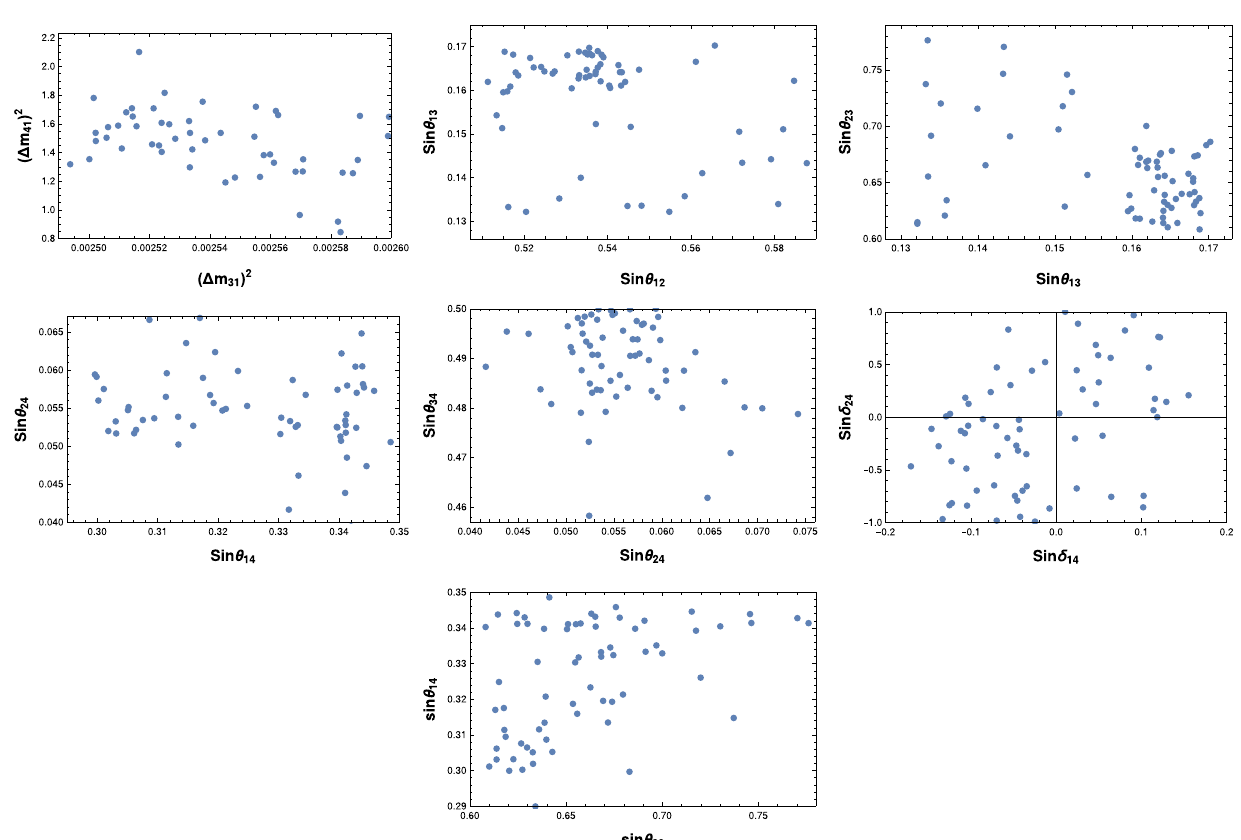
Fig. 5 Neutrino oscillation parameters in active-sterile sector for case (x) from texture 1 zero category for NH